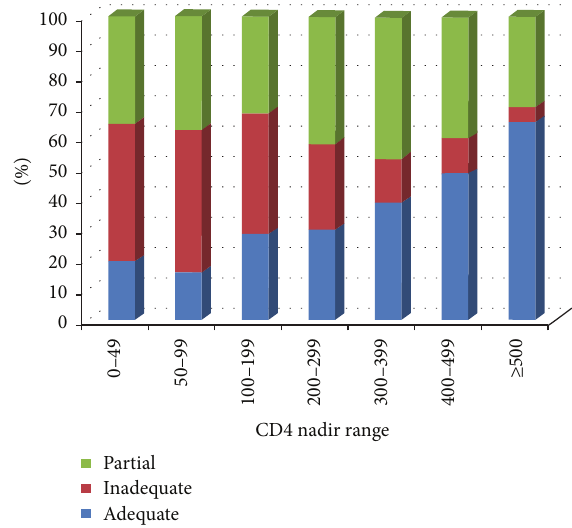
Figure 1: Proportion of patients reaching inadequate, partial, or adequate immune restoration, according to mean CD4 count